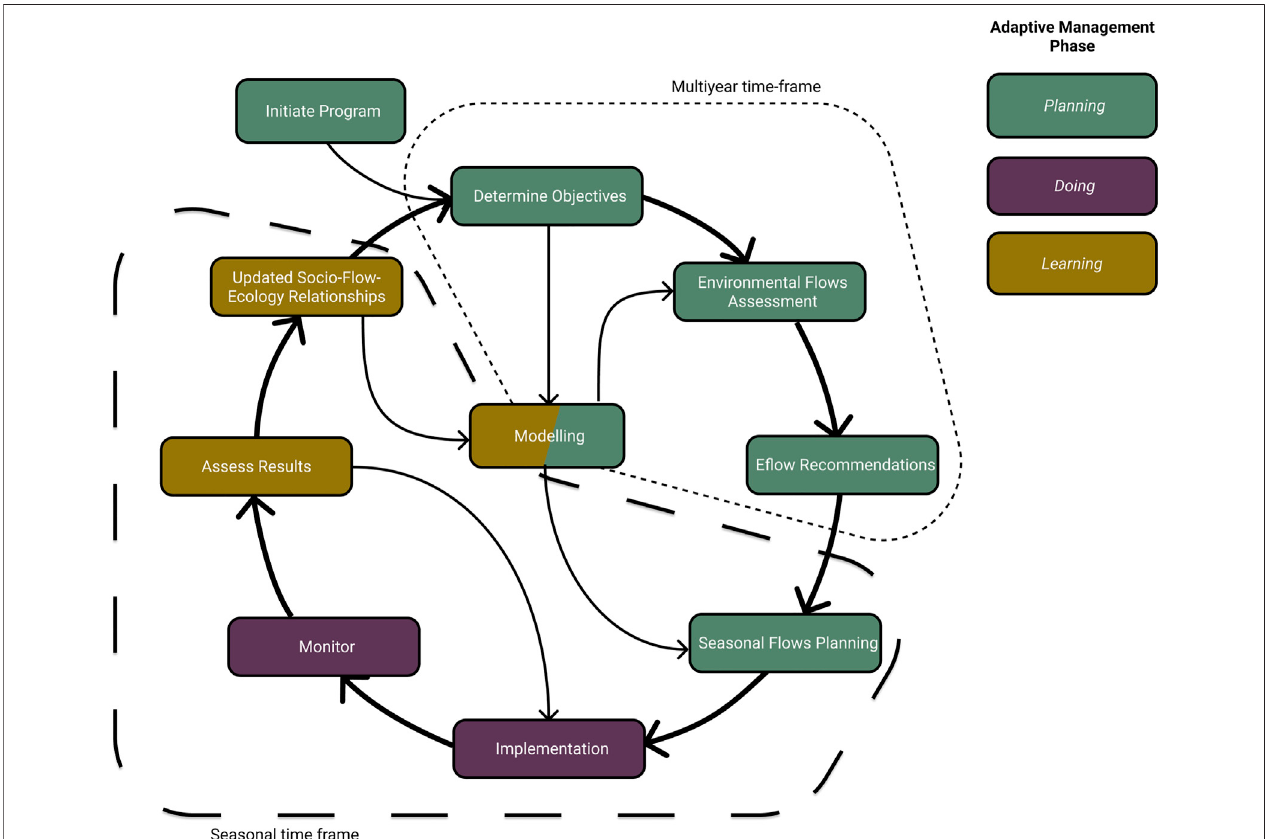
FIGURE1| Thephases ofadaptivemanagementine- fl ows:Planning(showningreen),Doing(showninpurple) andLearning(showningold).Theboxesshowthe activities involved in e- fl ows adaptive management. The majority of planning takes place within a longer multi-year time frame while doing and learning takes place on a seasonal and ongoing basis. The e- fl ows activities here correspond directly with the activities described in Table 3 .